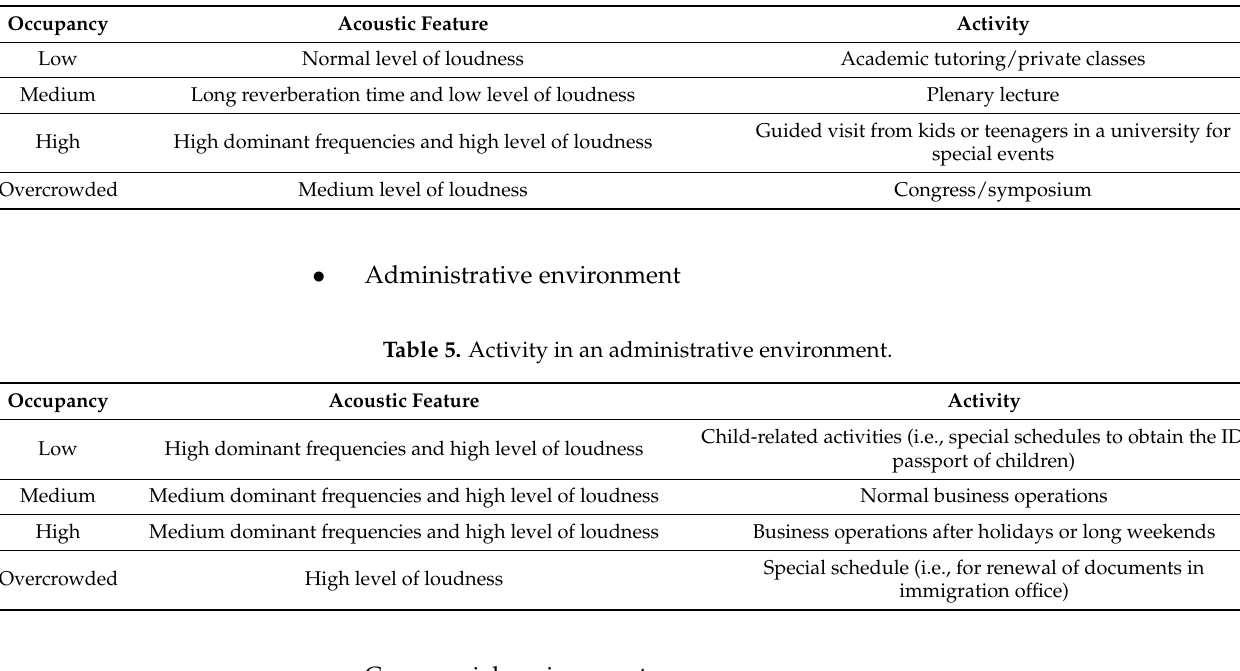
Table 4. Activity in an academic environment.